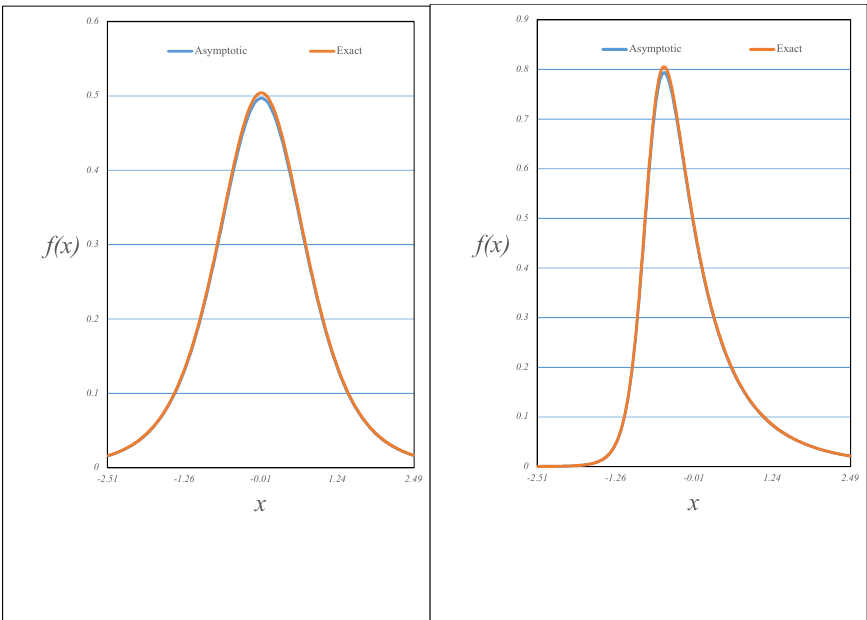
Figure 11. Asymptotic and exact skew-Student density functions, ν = 5, τ = −